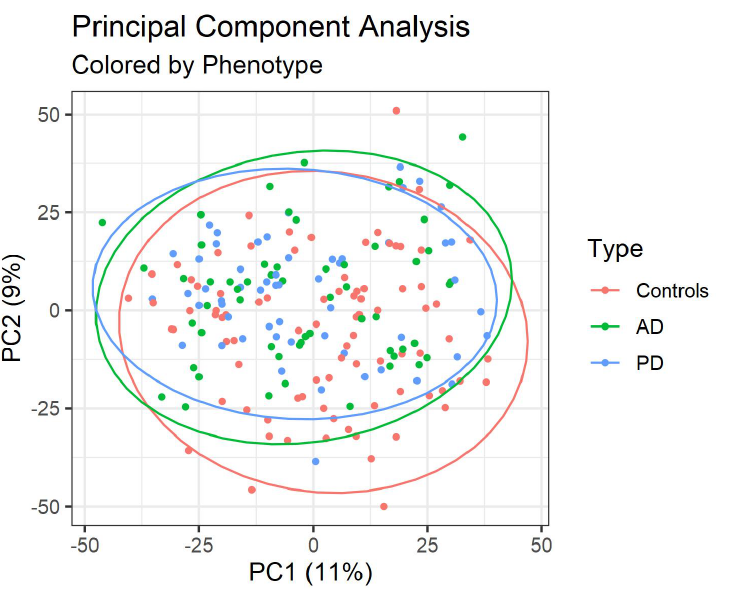
Figure 1. Untargeted data projected onto the first two Principal Components (PC). Each point represents a subject, colored by their phenotype. Percentages in the axis titles refer to the percentage of variation of the data explained by the respective PC. In addition, 95% confidence ellipses assuming the t -distribution are also plotted. The first two principal components do not clearly separate the disease